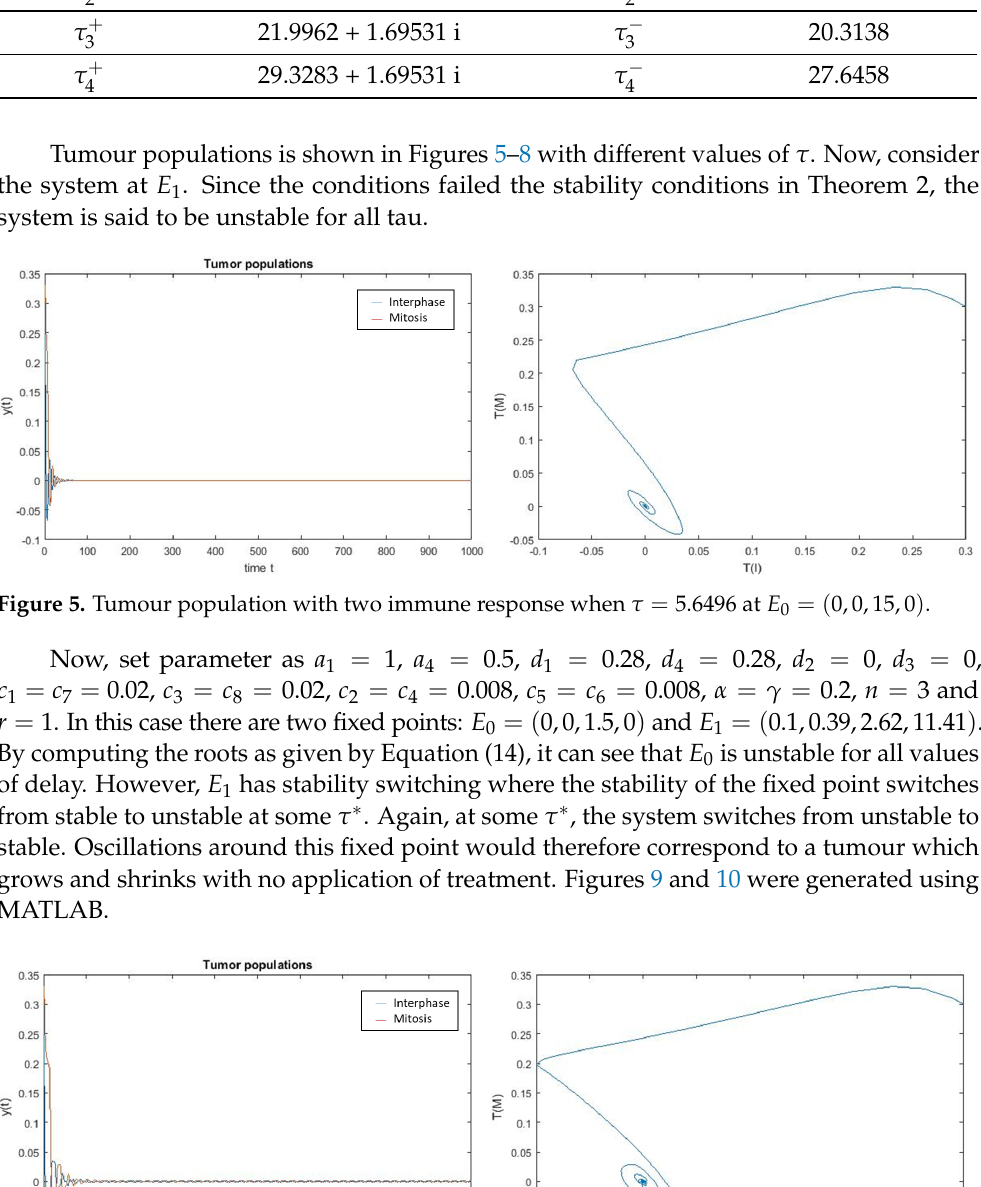
Table 2. Values of τ +